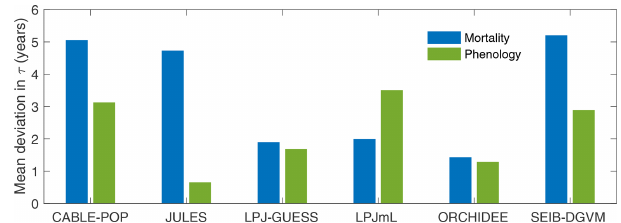
Figure 4. Mean absolute deviation in τ turn across all grid cells with at least 10% forest cover as a result of using global mean values of mortality ( F mort ) or phenology ( F phen = F leaf + F fineroot + F repro ) turnover fluxes in the calculation of F turn in Eq. (2) (see “Meth- ods”). Larger values indicate a greater contribution of F mort (blue) or F phen (green) to spatial variability in τ turn . Calculated over the period 1985–2014 from the CRU-NCEP-forced